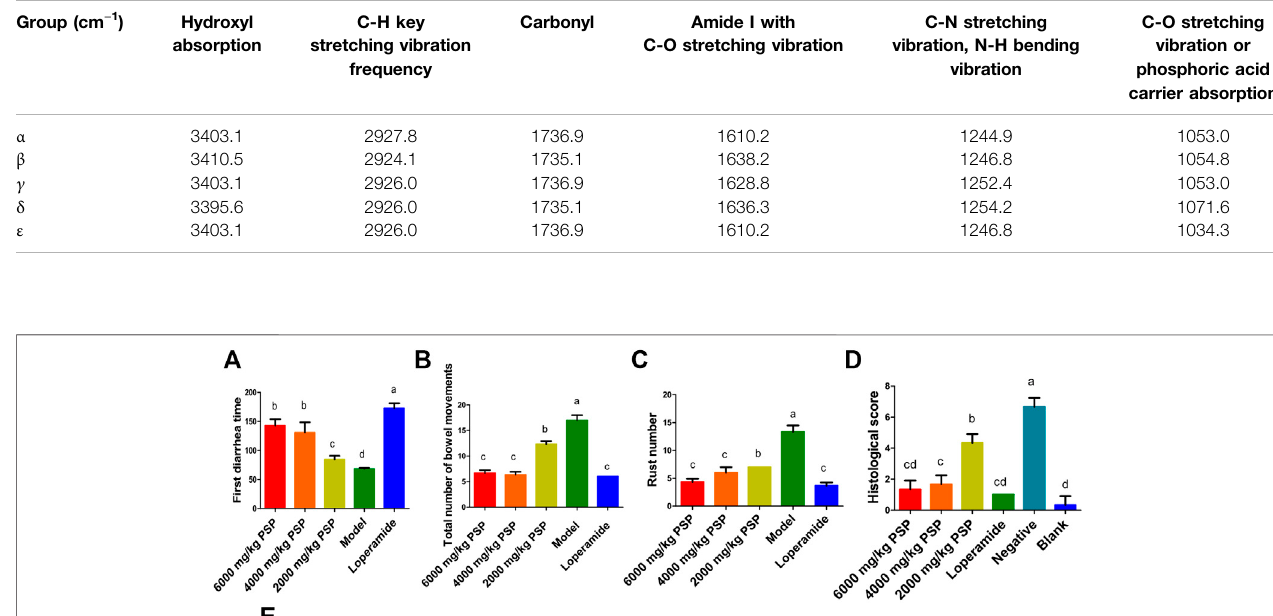
Frontiers in Pharmacology |